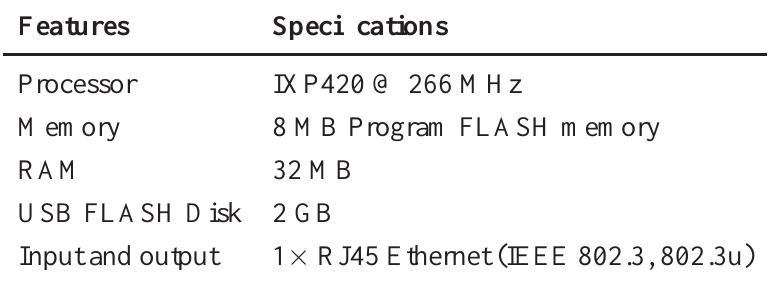
Table 3. Prototype of high bandwidth base stations Stargate NetBridge.